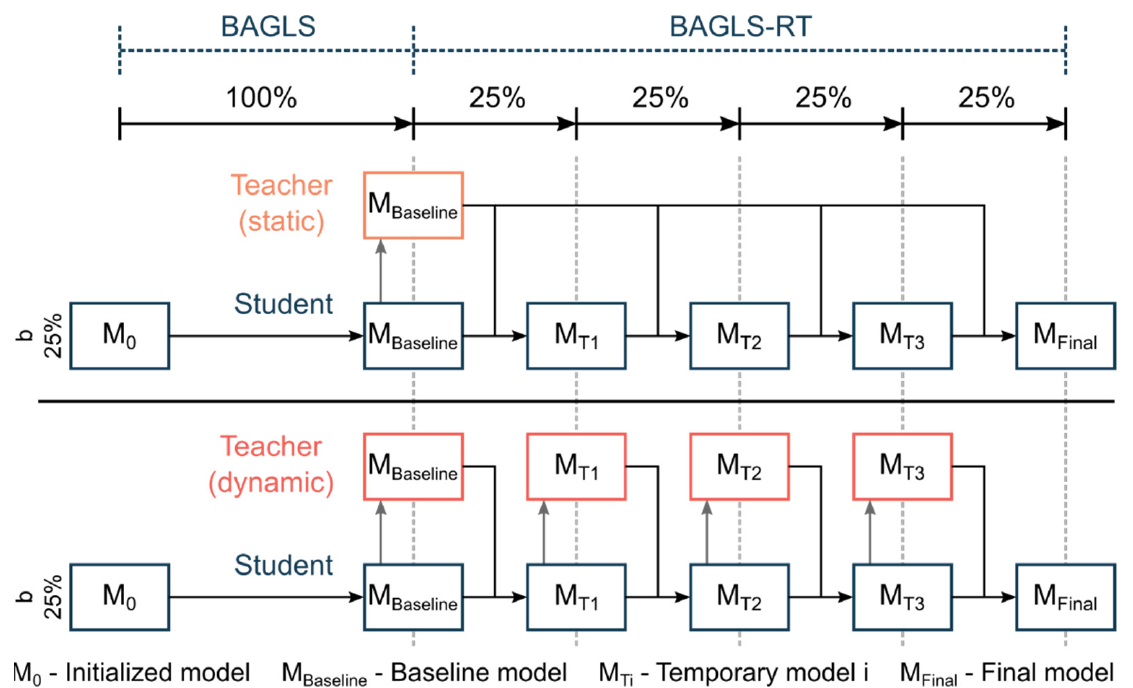
Figure 9. Illustration of the finetuning process using knowledge distillation with a static and dynamic teacher model, exemplarily given for b = 25%.